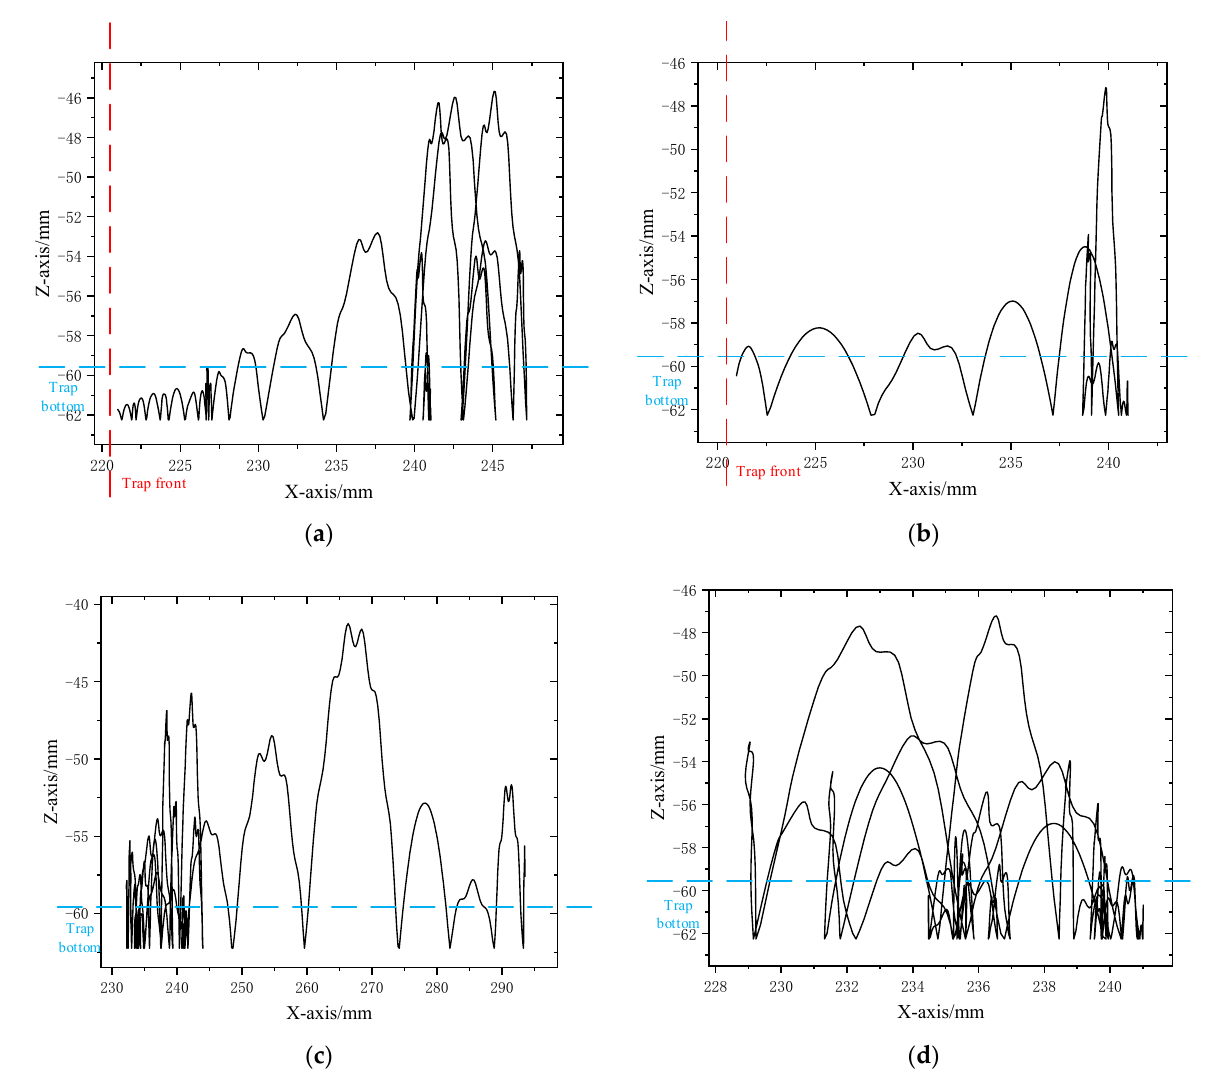
Figure 8. Particle trajectories considering angle: ( a ) case 1, ( b ) case 2, ( c ) case 3, and ( d ) case 4.